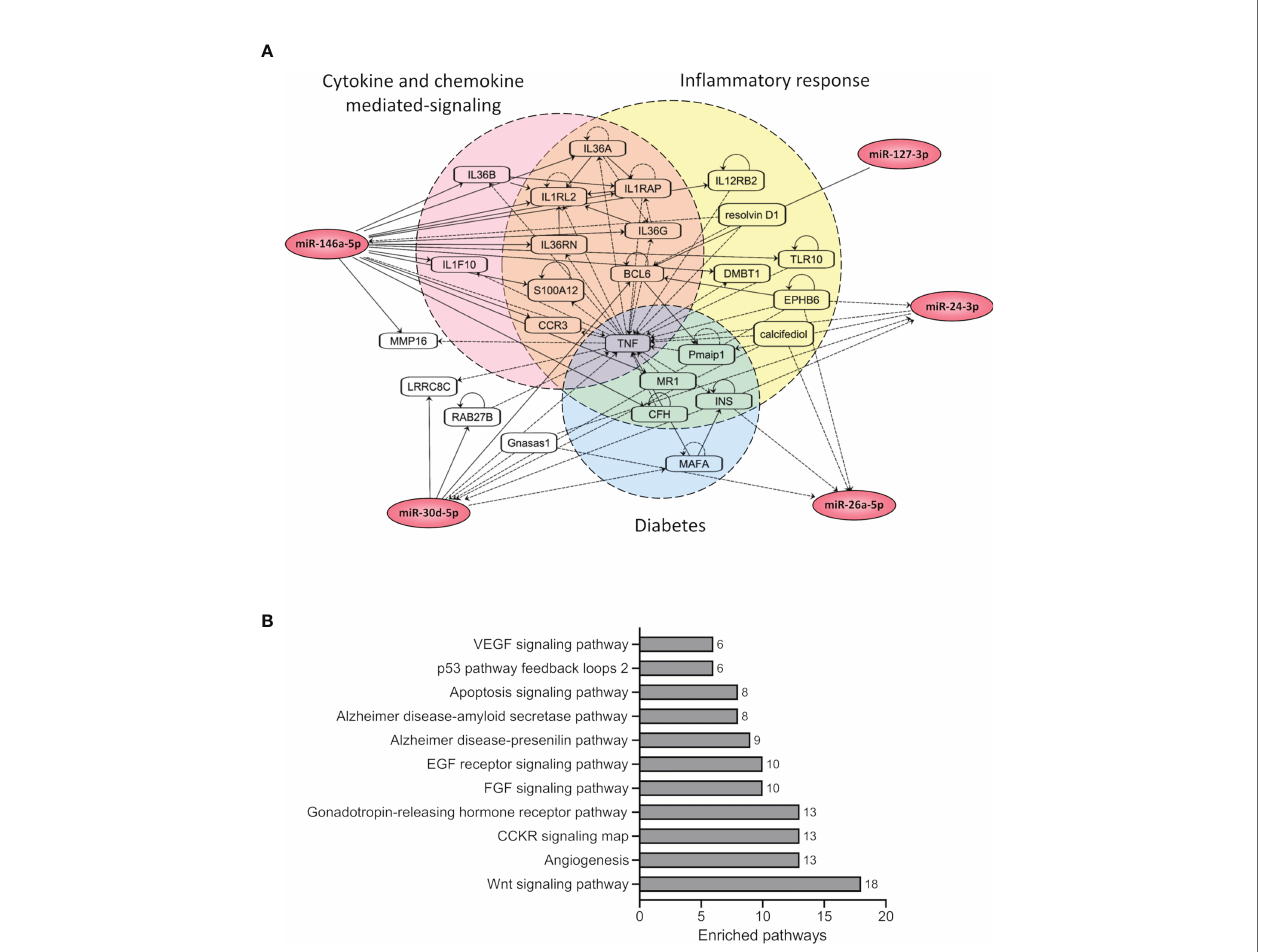
FIGURE 3 | Network and pathway-based analysis of miRNA targets revealed enrichment for cellular signaling pathways. (A) The fi gure shows the network of the target genes associated with selected 5 miRNAs (hsa-miR-146a-5p, hsa-miR-26a-5p, hsa-miR-24-3p, hsa-miR-30d-5p, and hsa-miR-127-3p). The target genes were grouped based on their pathway annotations in IPA. (B) The fi gure shows enriched pathways associated with the target genes of the selected 5 miRNAs based on PantherDB annotations. Only signi fi cant pathways with FDR <0.05 are shown. The total number of target genes from the input list associated with each enriched pathway are also